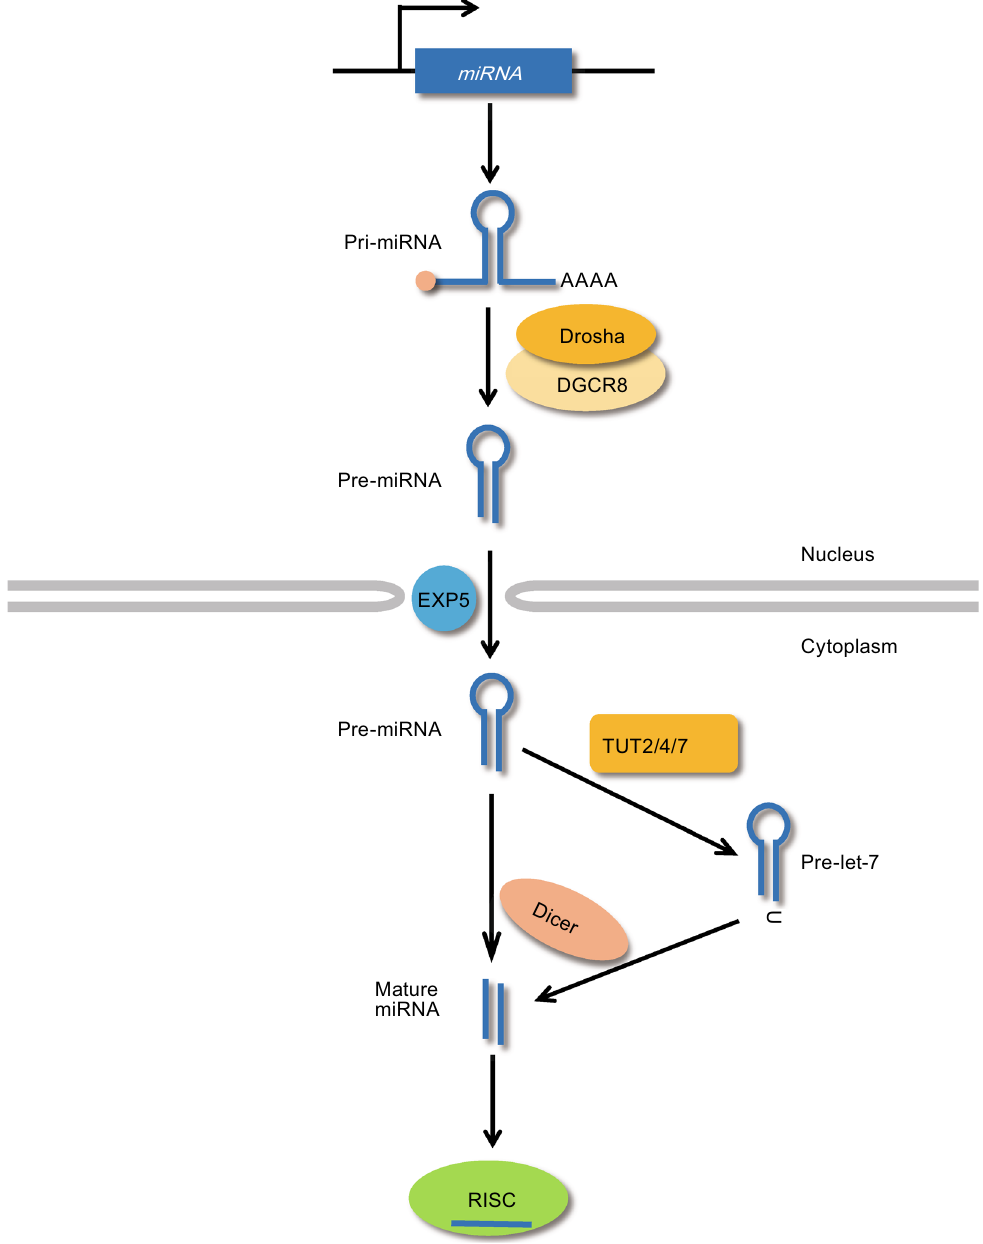
Figure 3. Canonical pathway of miRNA biogenesis. Schematic diagram of the canonical miRNA biogenesis process. A primary miRNA transcript produced by RNA polymerase II is processed by the Drosha microprocessor in the nucleus. The generated pre- miRNA is transported to the cytoplasm in an EXP5-Ran-GTP-dependent manner and further processed by the Dicer microprocessor to generate a mature miRNA. Pre-let-7 is mono-uridylated at the 3 ′ end by LIN28A and TUTases prior to Dicer-mediated processing. The mature miRNA is loaded onto RISC to inhibit the translation of a target